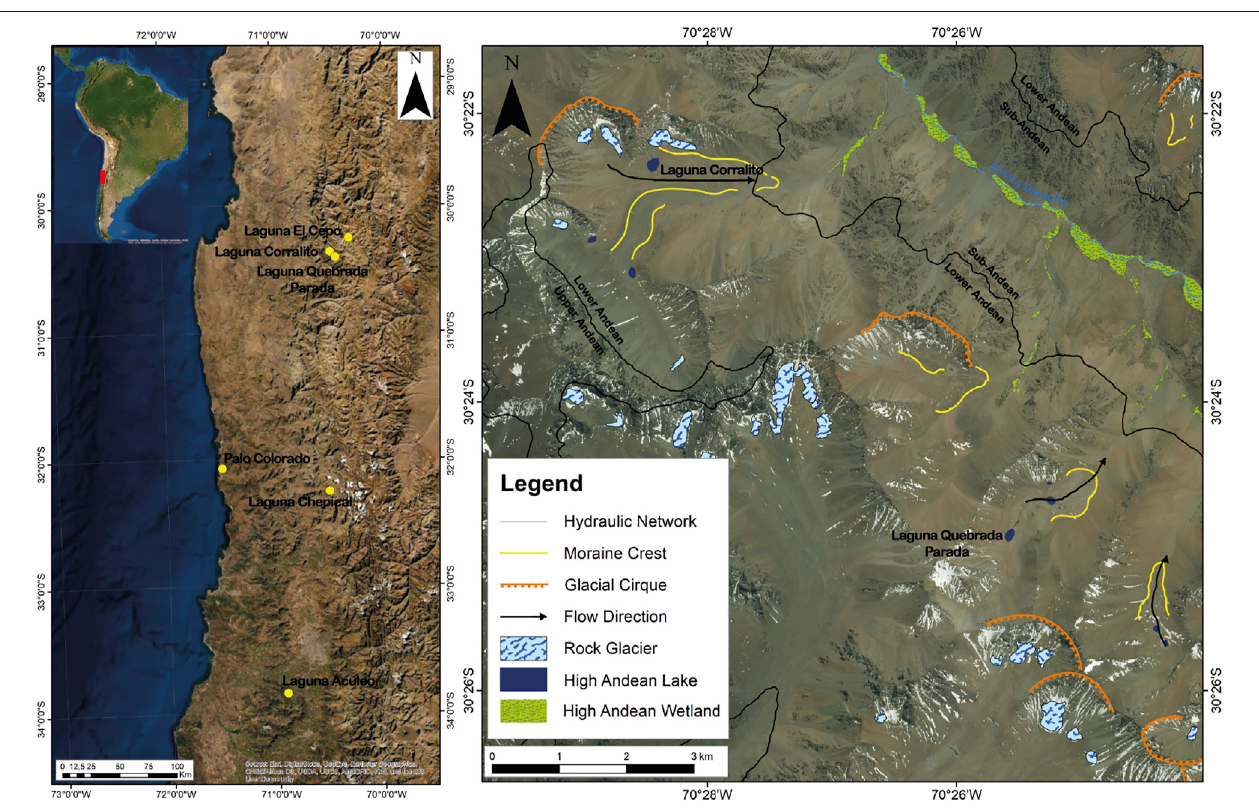
FIGURE 1 | Map of the study area showing the location of lakes analyzed, the main geomorphological characteristics of the area, and sites discussed in the text.